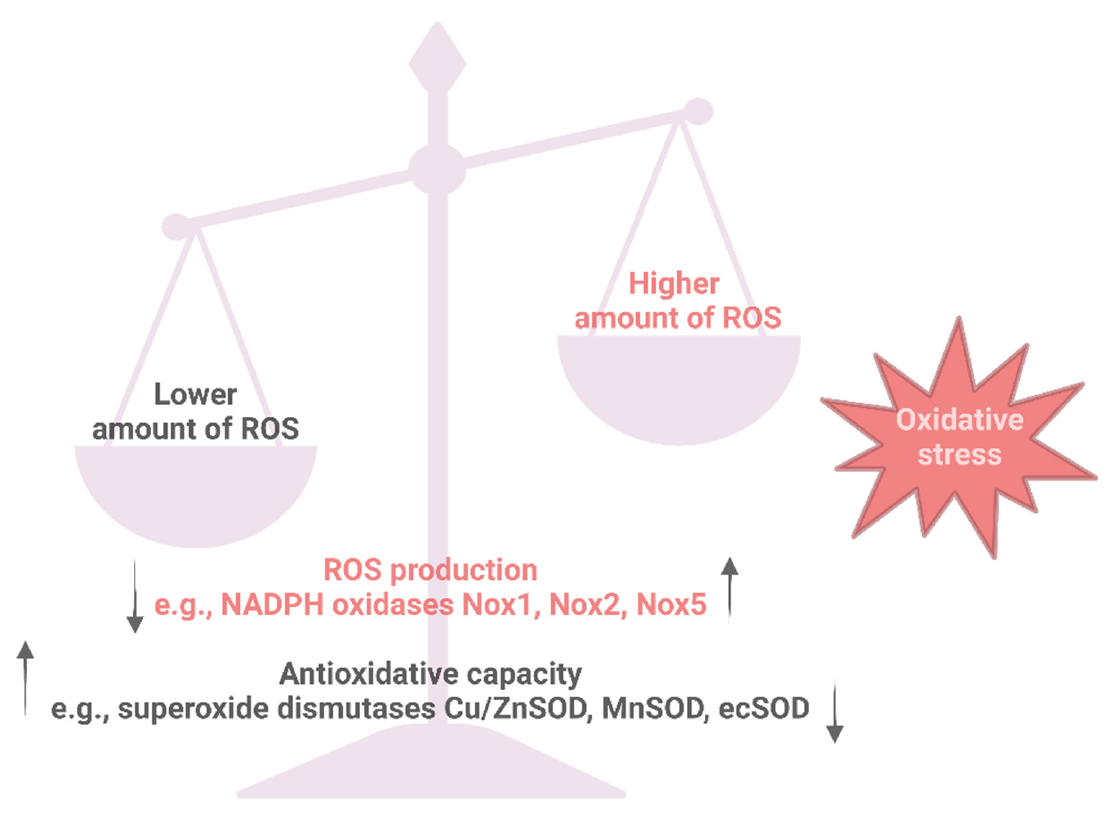
Figure 2. Physiological redox balance and oxidative stress. Under physiological conditions, the production of reactive oxygen species (ROS) and the antioxidative capacity are in a balance. An in- creased production of ROS, e.g., by NADPH oxidase (NOX) isoforms 1, 2 and 5, which is not com- pensated by antioxidative defense mechanisms like the different superoxide dismutase (SOD) isoforms, can lead to oxidative stress. Created with BioRender.com.